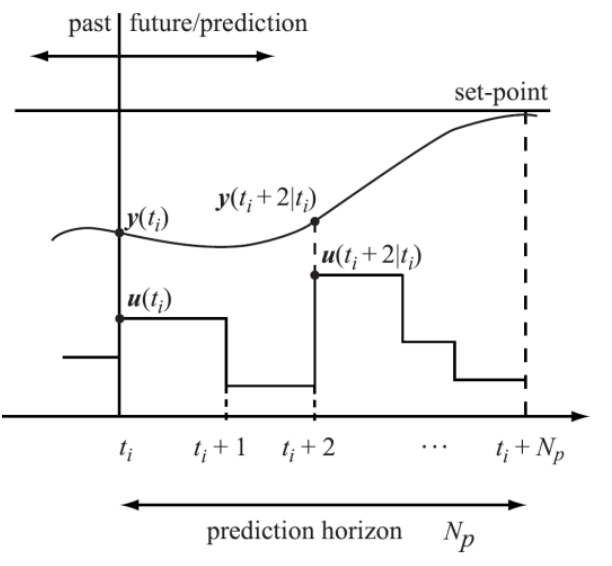
Figure 16. Controller action construction using model-based predictive control (MPC)